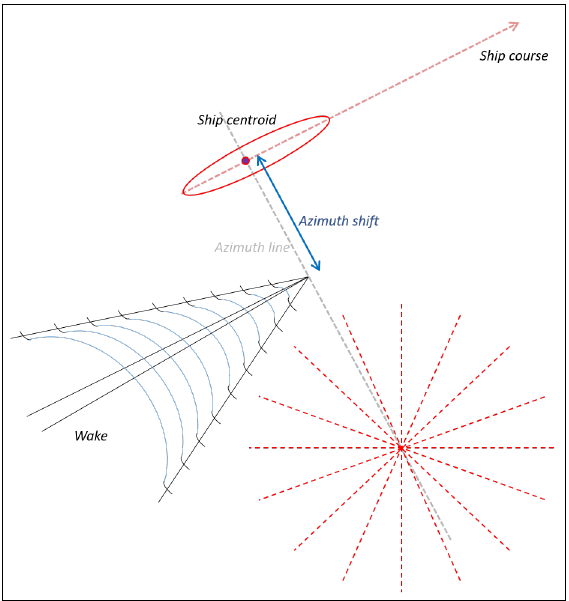
Figure 10. Wake Pattern formation and representation in SAR remote sensing and punctual radon